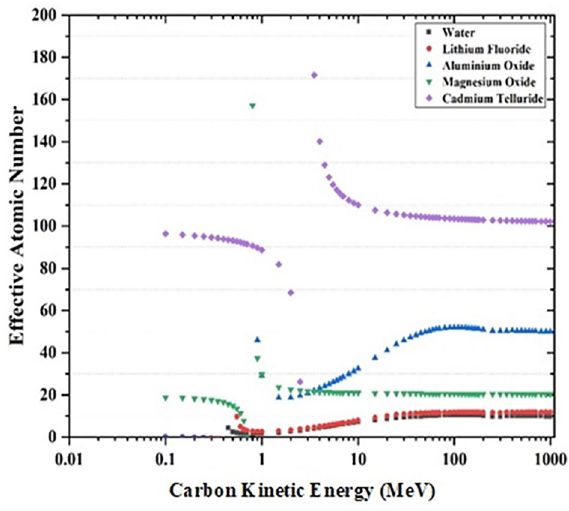
Figure 4. Variation of Z eff with kinetic energy of Carbon for water, lithium fluoride, aluminum oxide, magnesium oxide, and cadmium telluride. At low energies the effective atomic number is close to the number of electrons in molecular unit of